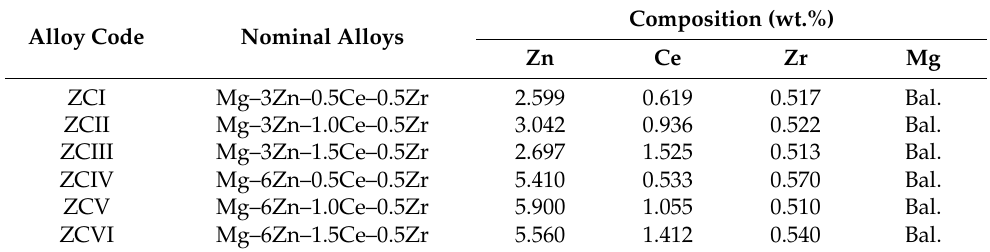
Table 1. Design composition and measured composition of Mg–Zn–Ce–Zr alloys. Alloy Code